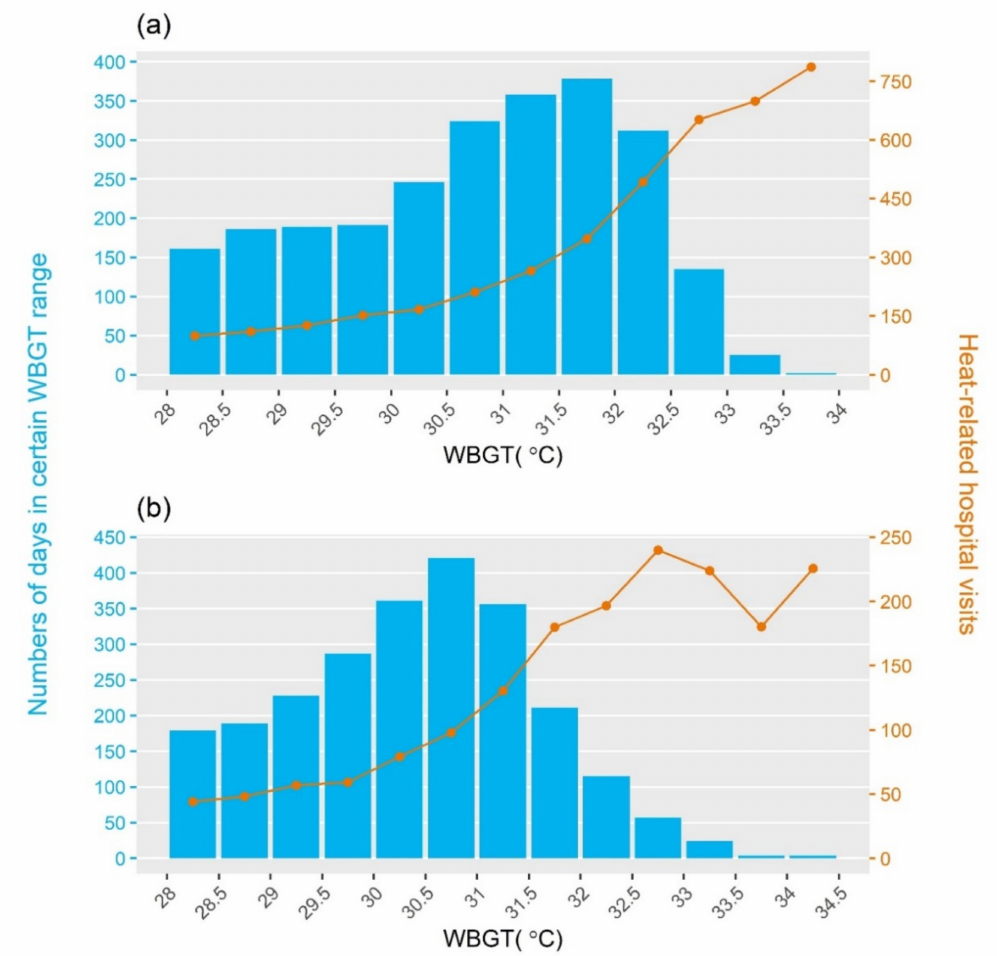
Figure 1. Relationship of WBGT with heat-related hospital visits for ( a ) whole of Taiwan and ( b ) Central Taiwan. The blue bars denote numbers of days in a certain WBGT range, and the orange line indicates numbers of heat-related hospital visits. Rare events of WBGT above 33 ◦ C in Central Taiwan may cause fluctuations in counts of heat-related hospital